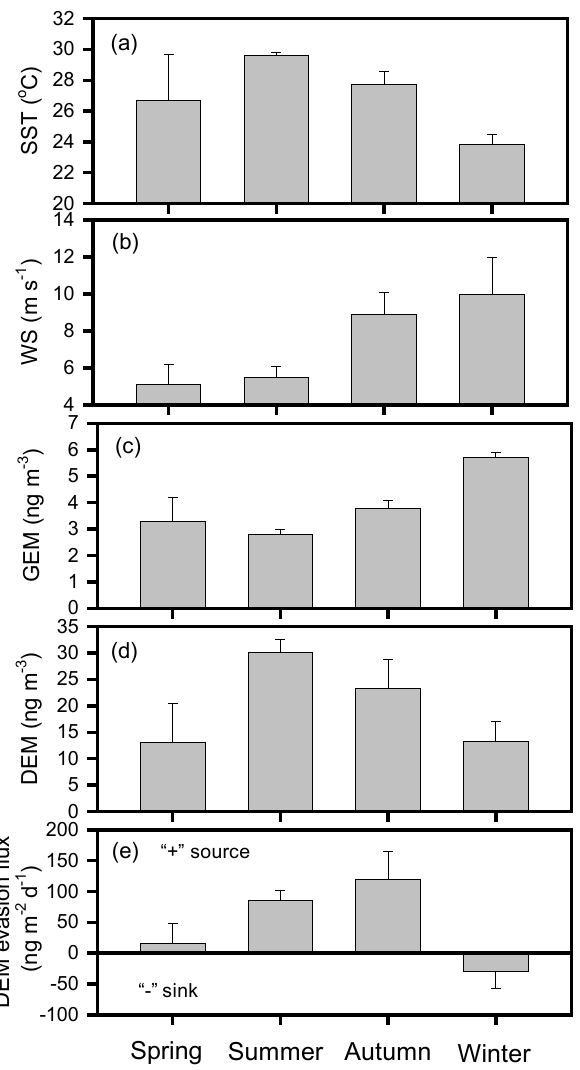
Fig. 4. Summary of seasonal average data for (a) SST; (b) WS; (c) GEM; (d) DEM and (e) air-sea Hg 0 exchange flux (i.e., averaged the values obtained from LM86 and W92) between 2003 and 2005 at SEATS station in the SCS. Each seasonal bar has an average of 3 cruises with an error of ± 1 SD ( n =